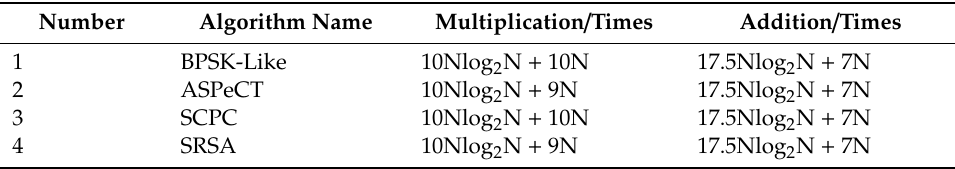
Table 1. Comparison calculation between four algorithms.